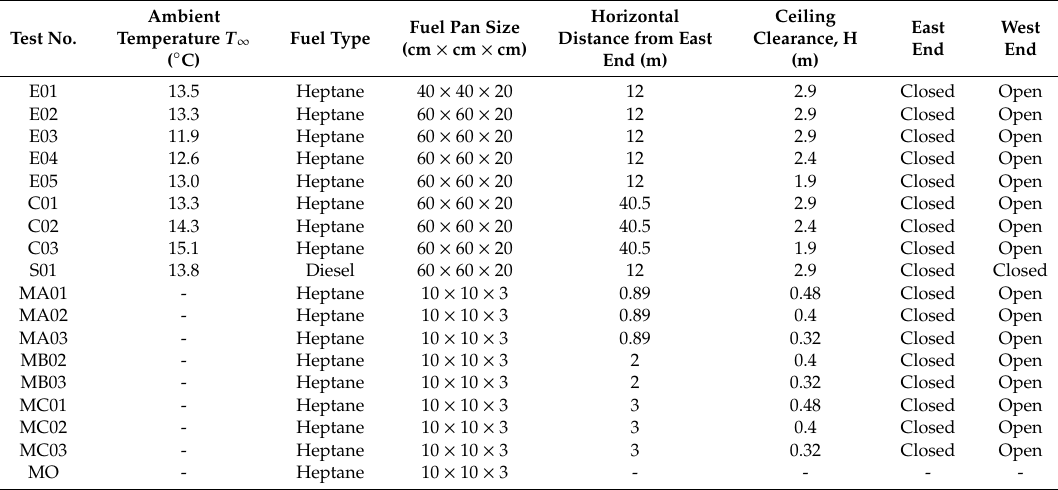
Table 1. Summary of the full-scale and model-scale tests.